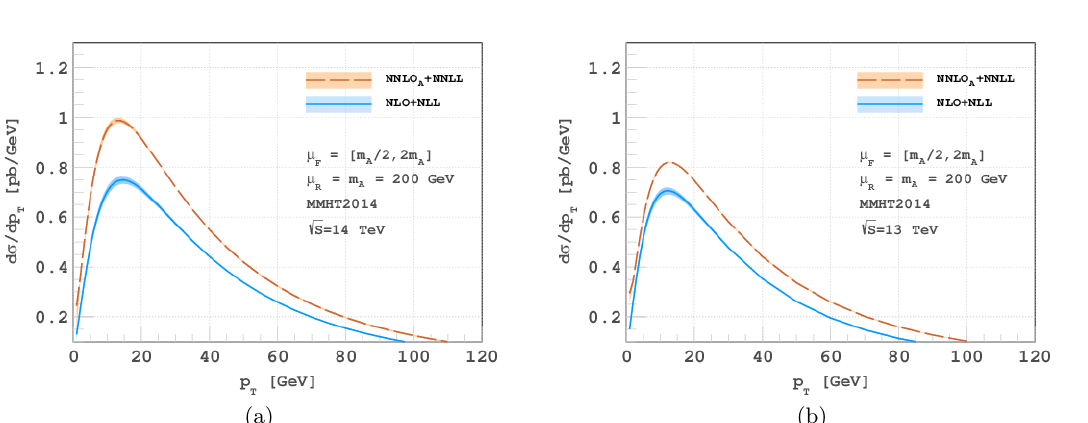
Figure 5 . Variation of (cid:22) F at NLO+NLL and NNLO A +NNLL keeping (cid:22) R (cid:12)xed at m A for